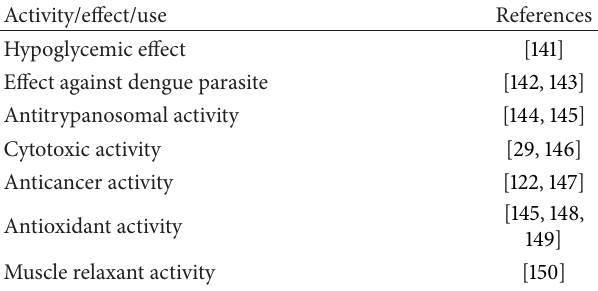
Table 3: Metal extraction by Parthenium hysterophorus plant. S. number